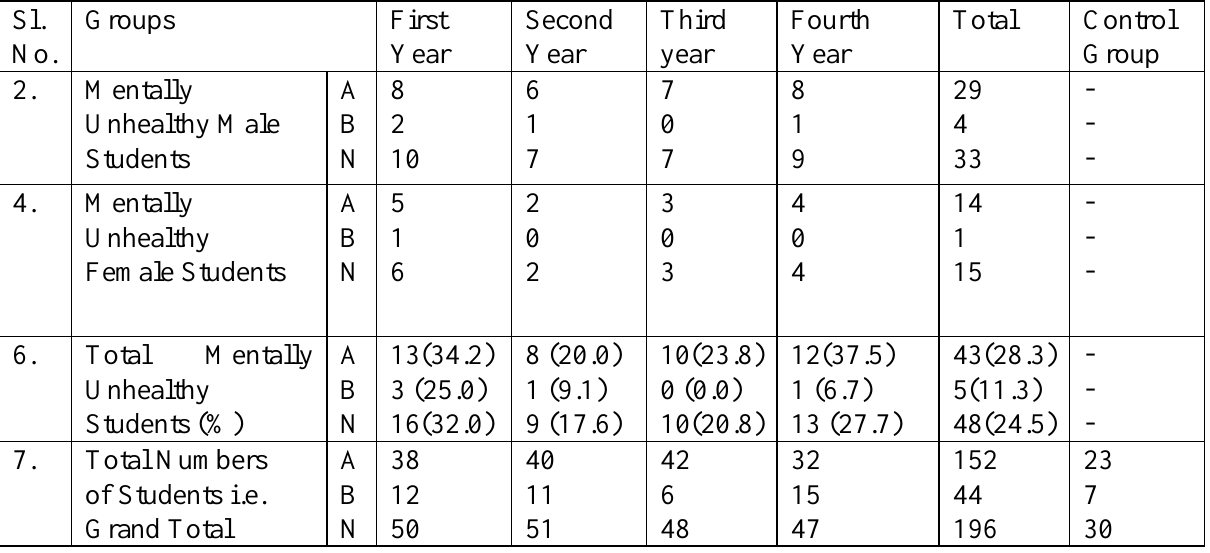
Table 4. Domicile distribution of mentally healthy and unhealthy Engineering students